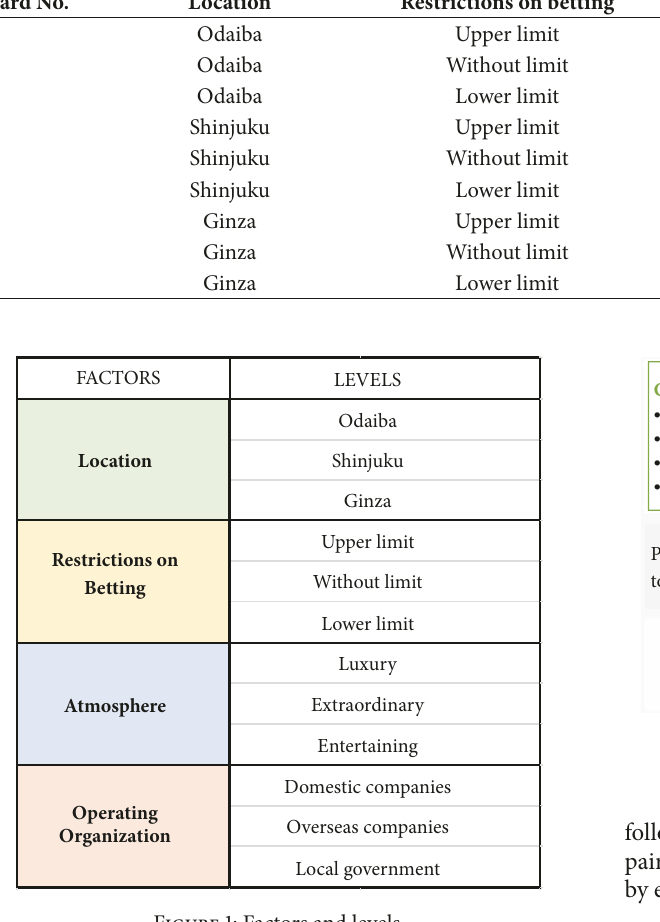
Figure 1: Factors and levels.